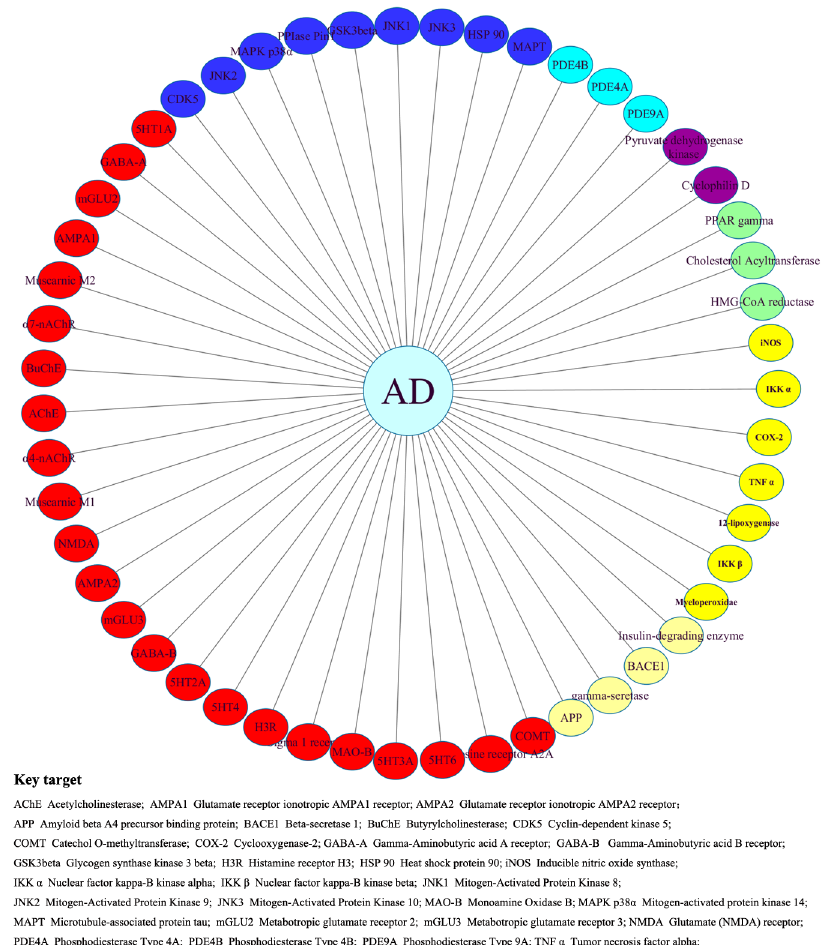
Fig 2. Summary of 51 key targets in